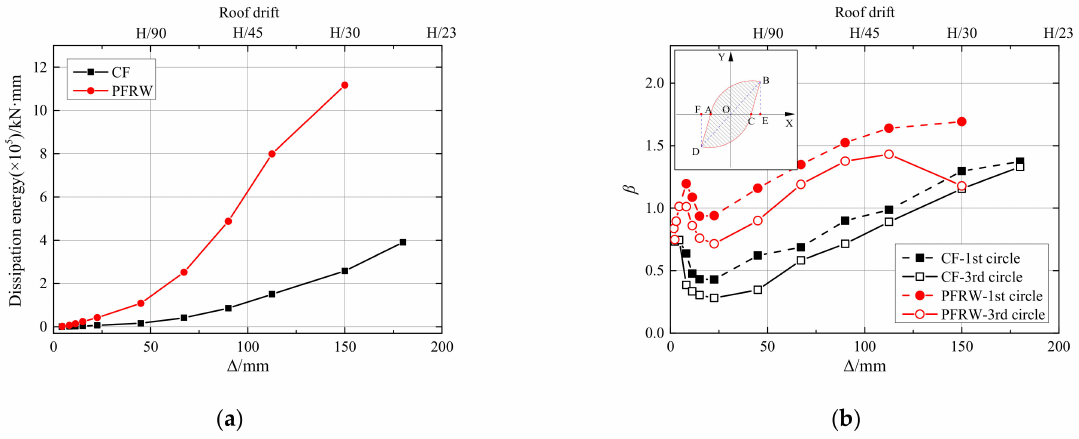
Figure 11. Energy dissipation performance of specimens. ( a ) Cumulative energy dissipation; ( b ) equivalent elastic damping.